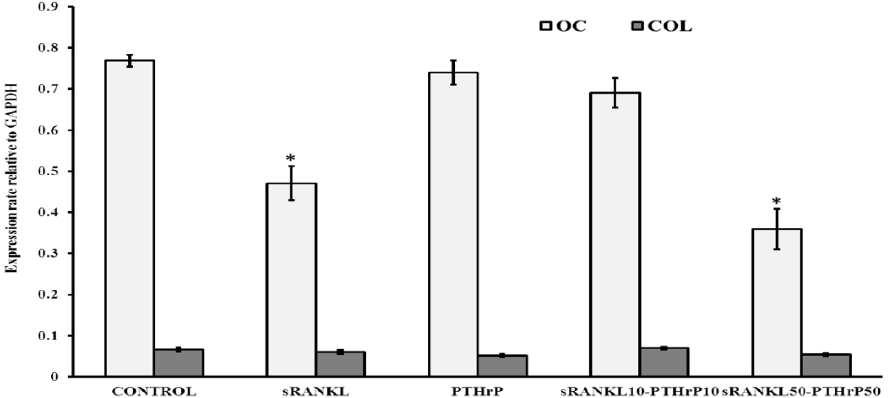
Figure 6. mRNA expression of differentiated MSCs by sRANKL and PTHrP. * p < 0.05 vs. control.